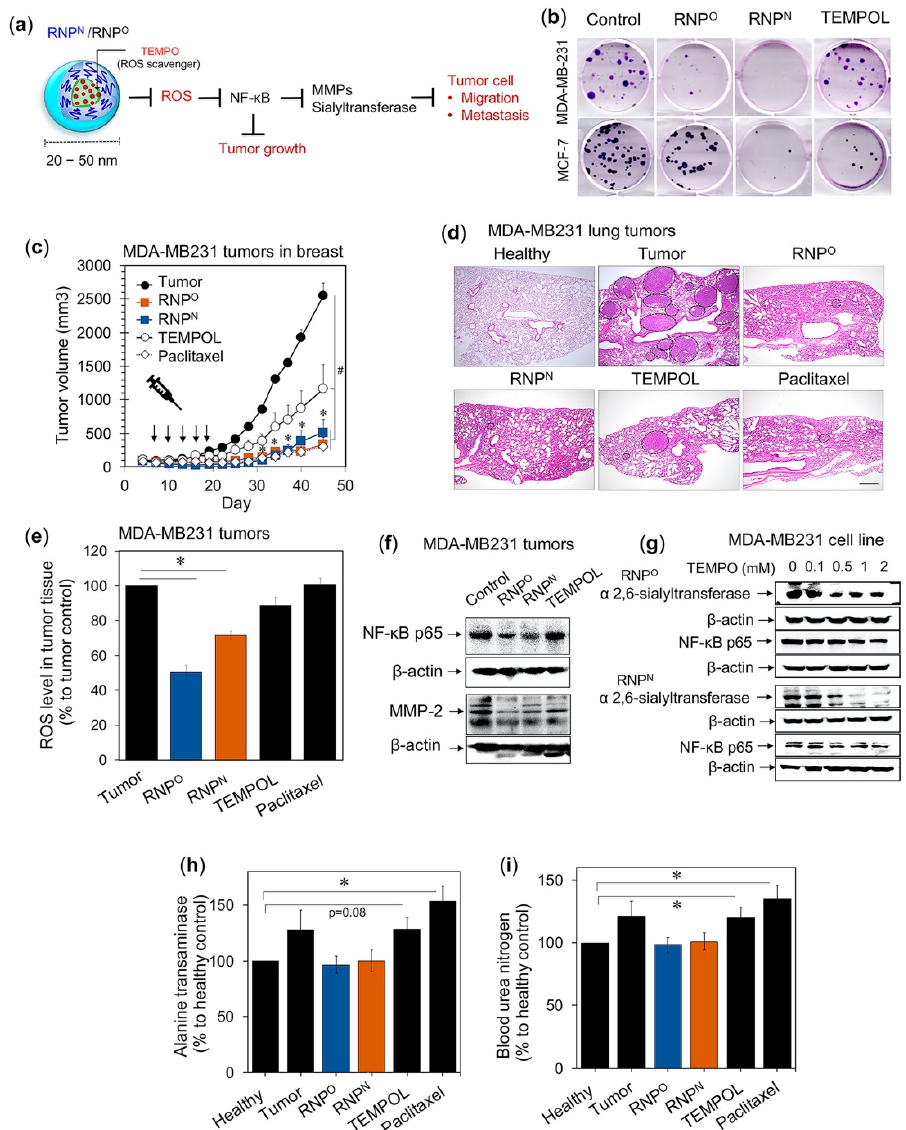
Figure 5. RNP N and RNP O inhibits the growth, proliferation, and metastatic potential of triple-negative breast cancer, MDA-MB231, with negligible adverse effects. ( a ) Schematic illustration of ROS-reduction mediated anti-tumor and anti- metastatic effect of RNPs. ( b ) Inhibition of colony-forming potential of breast cancer cell lines, MDA-MB231 and MCF-7 by RNP N , RNP O , and TEMPOL (IC 50 value, 48 h). ( c ) Tumor growth profile of breast cancer cell line (MDA-MB231) in the mice xenograft model, intravenously administered with RNP N , RNP O , TEMPOL (74.13 mg/kg of TEMPO concentration), and conventional anti-cancer drug paclitaxel (10 mg/kg). ( d ) Representative histopathological H and E-stained lung sections of MDA-MB231 experimental metastasis model mice, intravenously administered with RNP N , RNP O , TEMPOL (18.5 mg/kg of TEMPO concentration) and paclitaxel (5 mg/kg). The encircled areas are representing MDA-MB231 tumors. Scale bar 500 μ m. ( e ) ROS scavenging potential of RNPs in MDA-MB231 tumors detected by dihydroethidium compared to the untreated tumor as 100%. ( f ) Downregulation of MMP-2 and NF-kB expression by RNPs in MDA-MB231 tumors, as assessed by immunoblotting. ( g ) The ability of RNPs to suppress the expression of NF-kB and sialyltransferase, important enzymes assisting the metastasis of MDA-MB231 cell line, as assessed by immunoblotting [99]. Non-toxicity of RNPs as compared to LMW TEMPOL and paclitaxel after their intravenous administration, confirmed by liver and kidney damage markers: ( h ) alanine transaminase and ( i ) blood urea nitrogen, respectively. * p < 0.05 was considered significant [98]. This figure